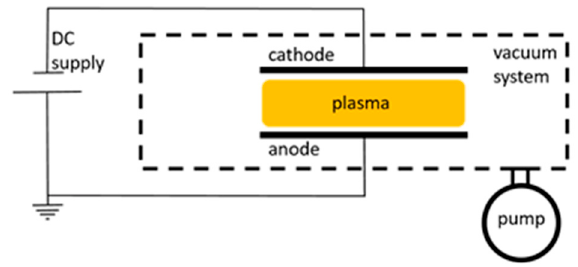
Figure 1. Schematic of a typical DC plasma system.